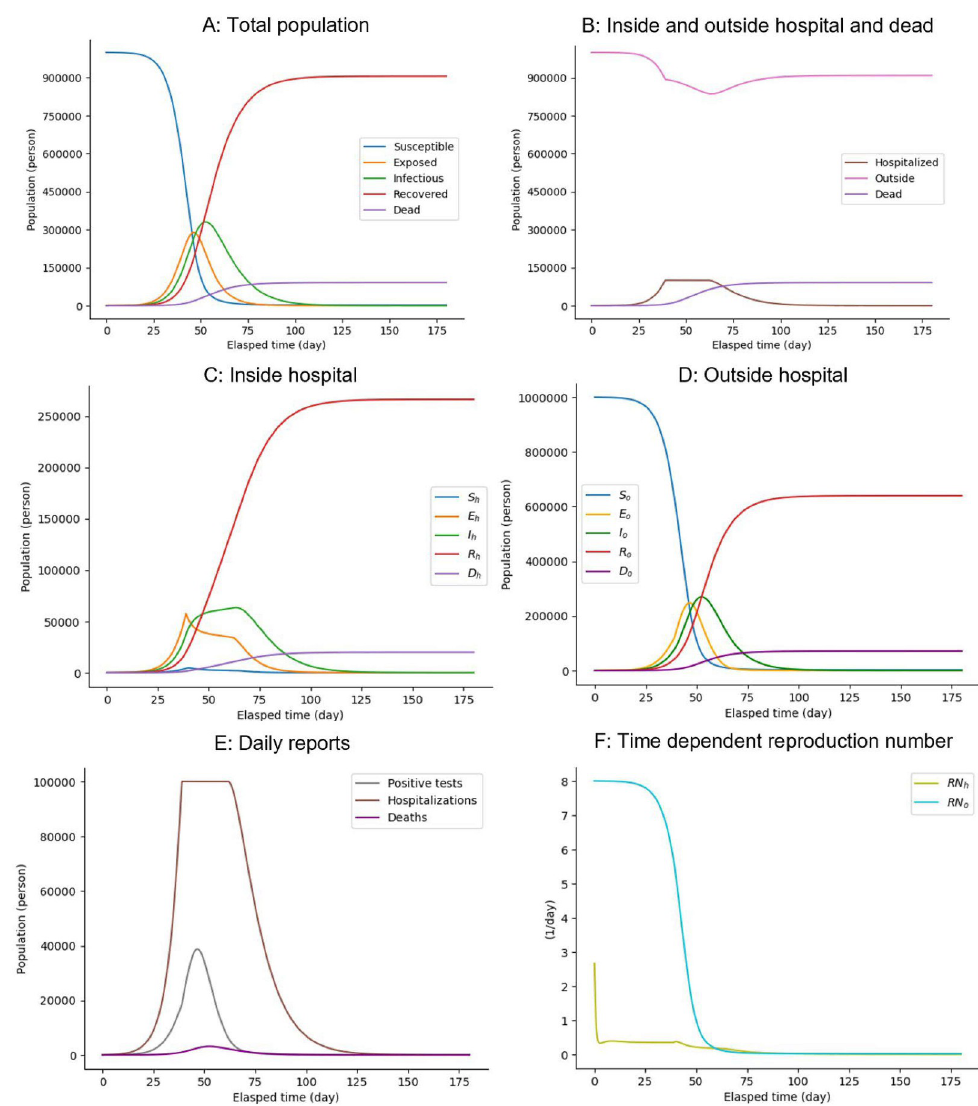
Fig 2. Changes in components over time in the testing-SEIRD model. Time-courses of (A) populations of all infectious states, irrespective of being inside and outside hospitals; (B) populations inside and outside hospitals and dead populations, irrespective of infectious states; (C) populations of all infectious states inside hospitals; (D) populations of all infectious states outside hospitals; (E) Daily reports of positive test results, hospitalizations, and deaths; and (F) Time-courses of reproduction numbers inside and outside hospitals, as described in Materials and Methods